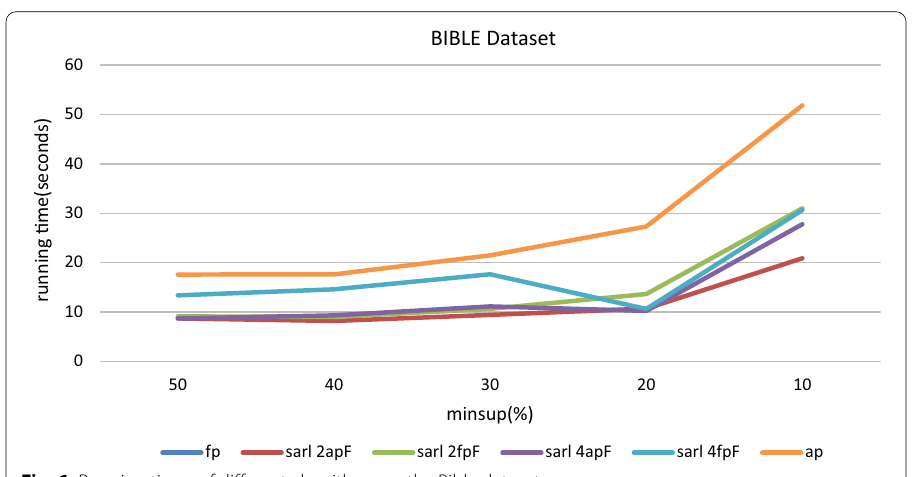
Fig. 6 Running times of different algorithms on the Bible